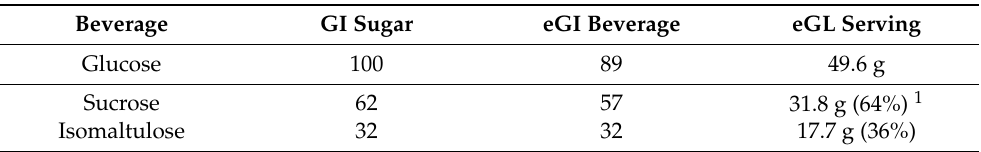
Table 1. Three test beverages featuring 50 g sugar dissolved in 125 mL semi-skimmed milk: glycemic Index (GI) of the sugars estimated GI of the beverage (eGI) and estimated Glycemic Load of a serving